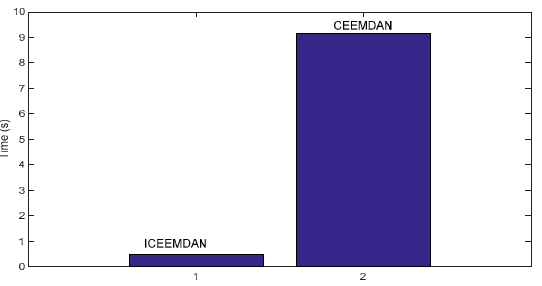
Figure 24. Comparison of extraction fault frequency for ECEEMDAN and CEEMDAN.